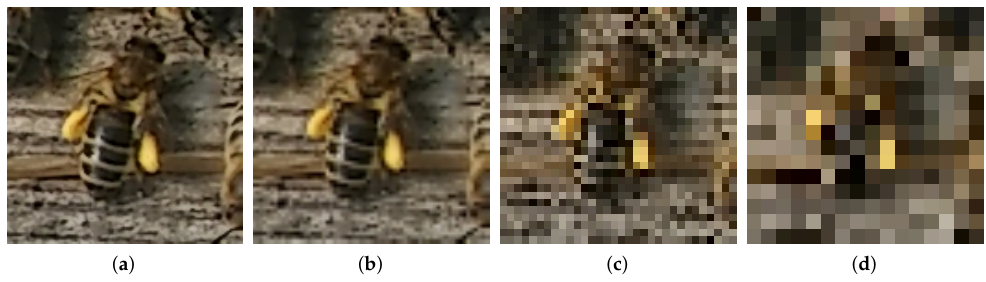
Figure 3. Pollen identifiability in raw image ( a ) and after image downsampling by × 2 ( b ), × 4 ( c ), and × 8 ( d ) on the input to the CNN and keeping the same ROI as in the raw image (yellow rectangles in Figure 2).